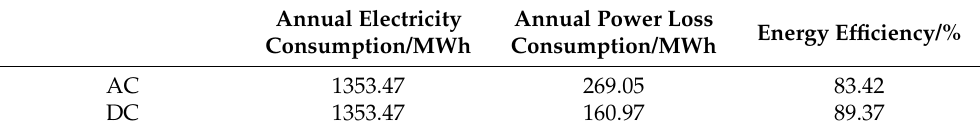
Table 6. The annual energy efficiency comparison of AC and DC